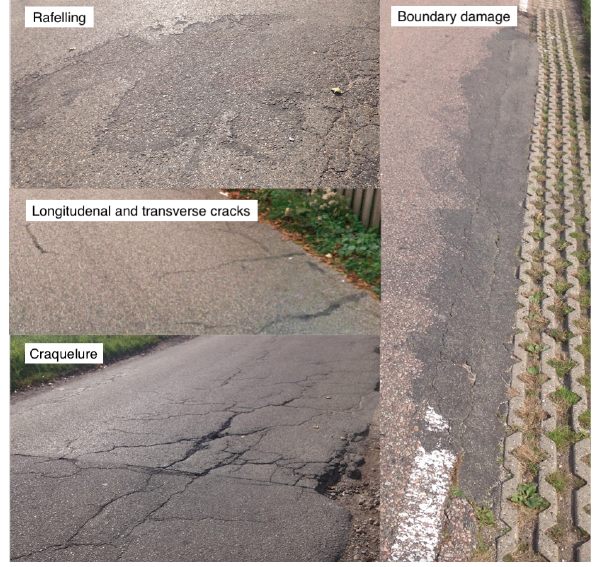
Figure 1. Examples of road surface